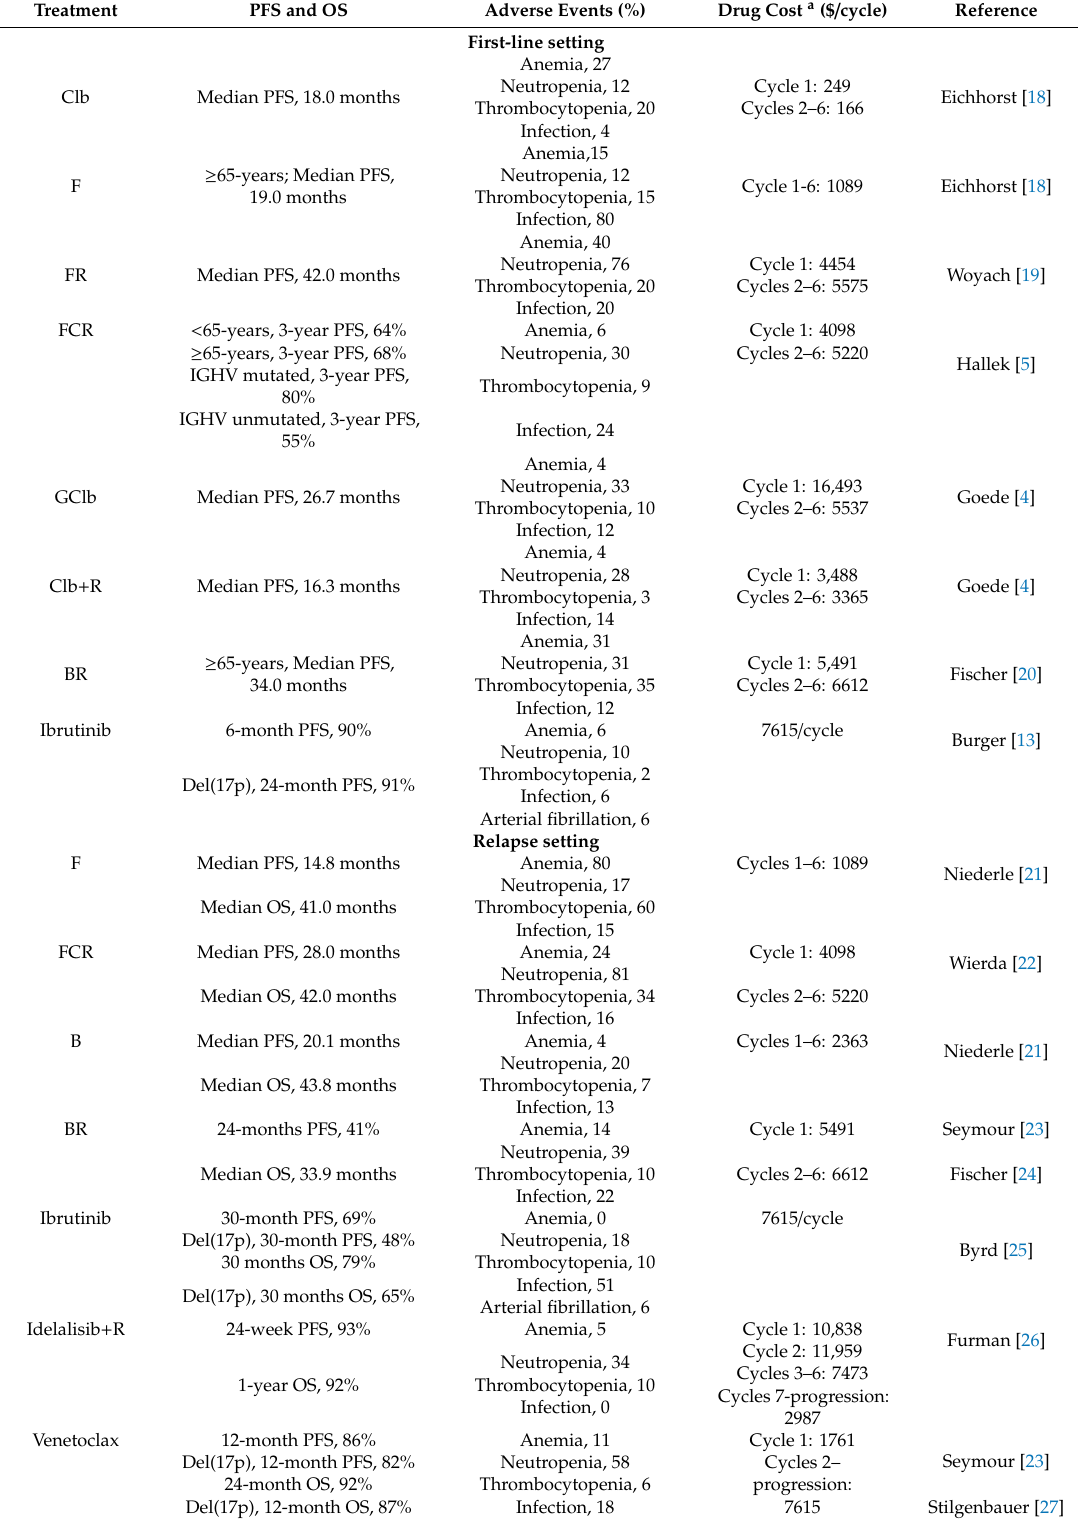
Table 2. Summary of Treatment-Related